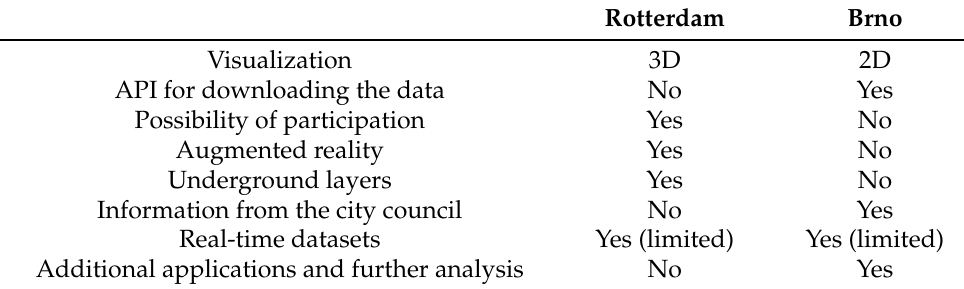
Table 2. Smart city platforms